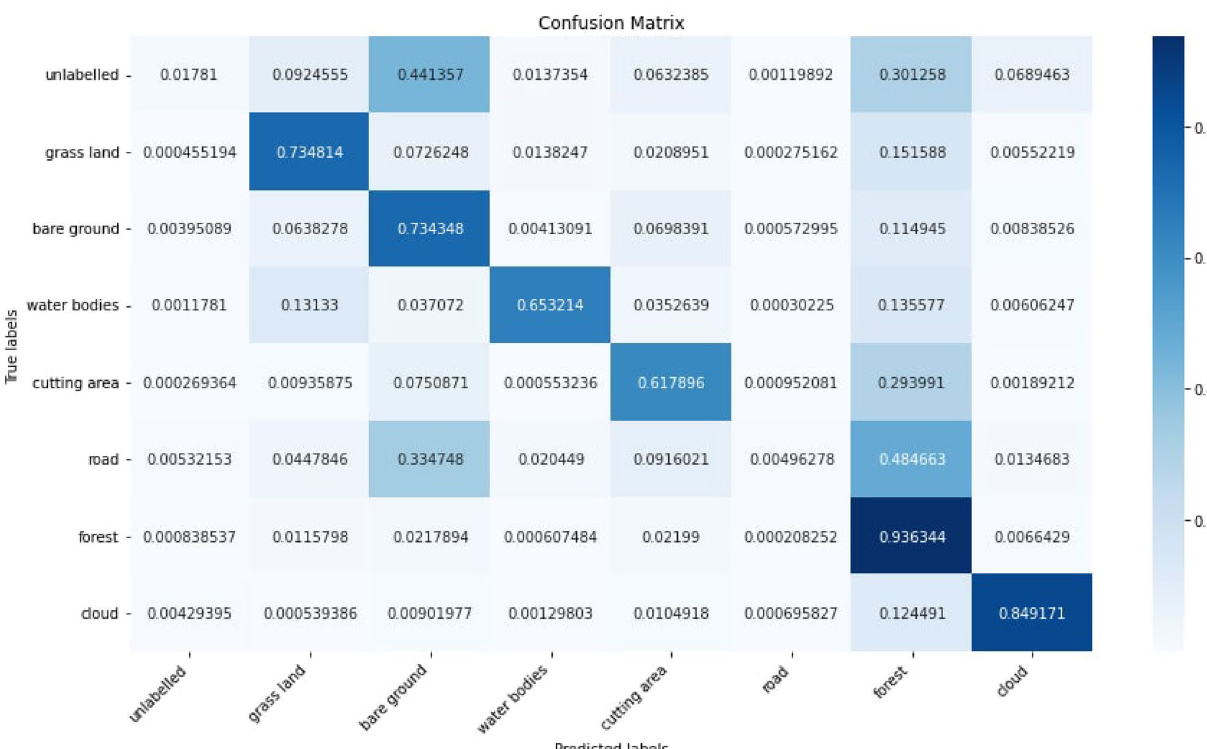
Bold values indicate best score